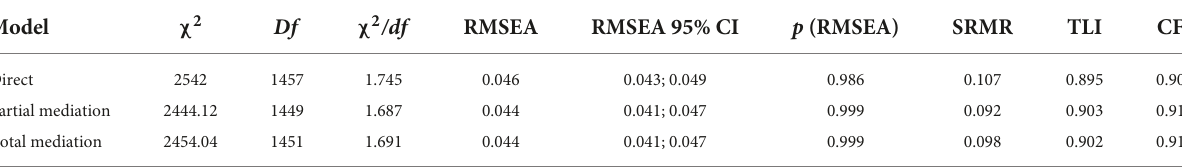
TABLE 2 Fit indexes for the different models ( N =